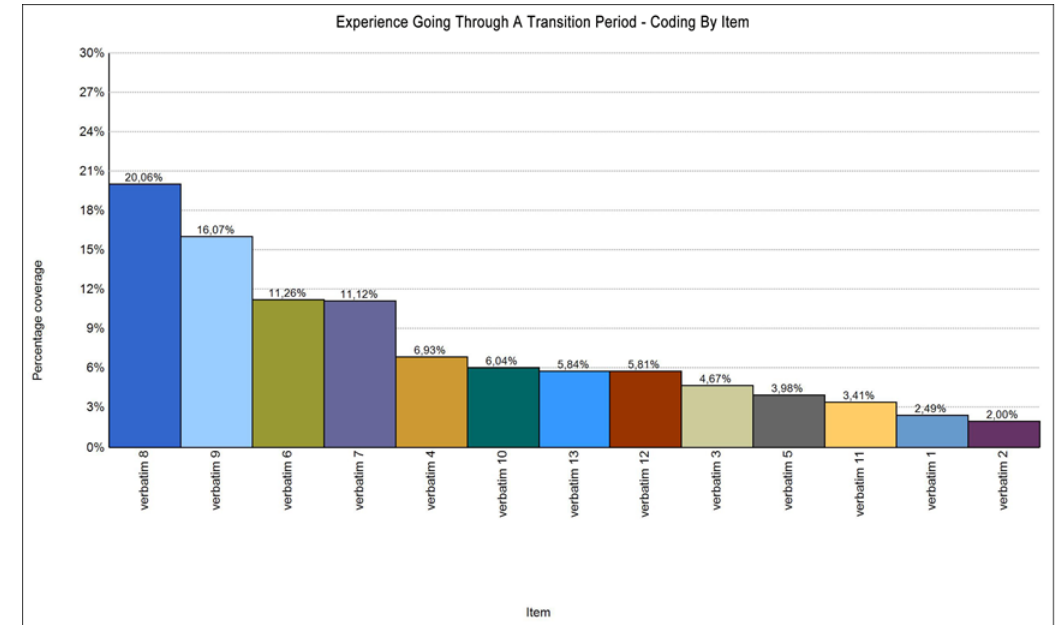
Fig. 9. Percentage showing the adaptive experiences during transition period